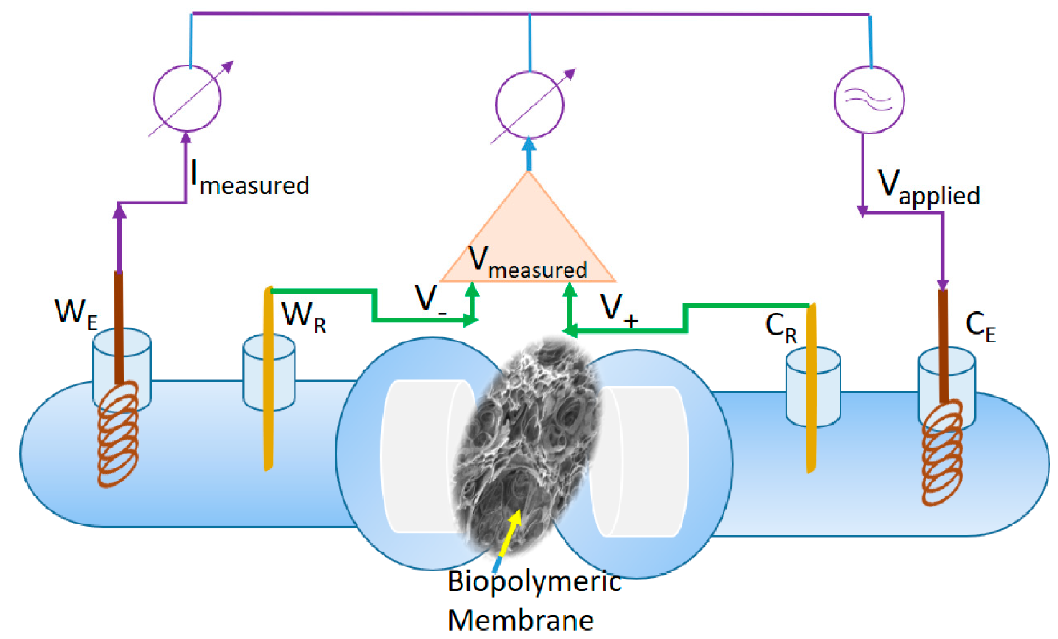
Figure 2. Scheme of the used impedance cell with four electrodes. W E —working electrode; W R —reference electrode associated with the W E ; C E —counter electrode; C R —reference electrode associated with the C E ; I measured is the measured current; V measured is the measured potential; V applied is the applied potential.